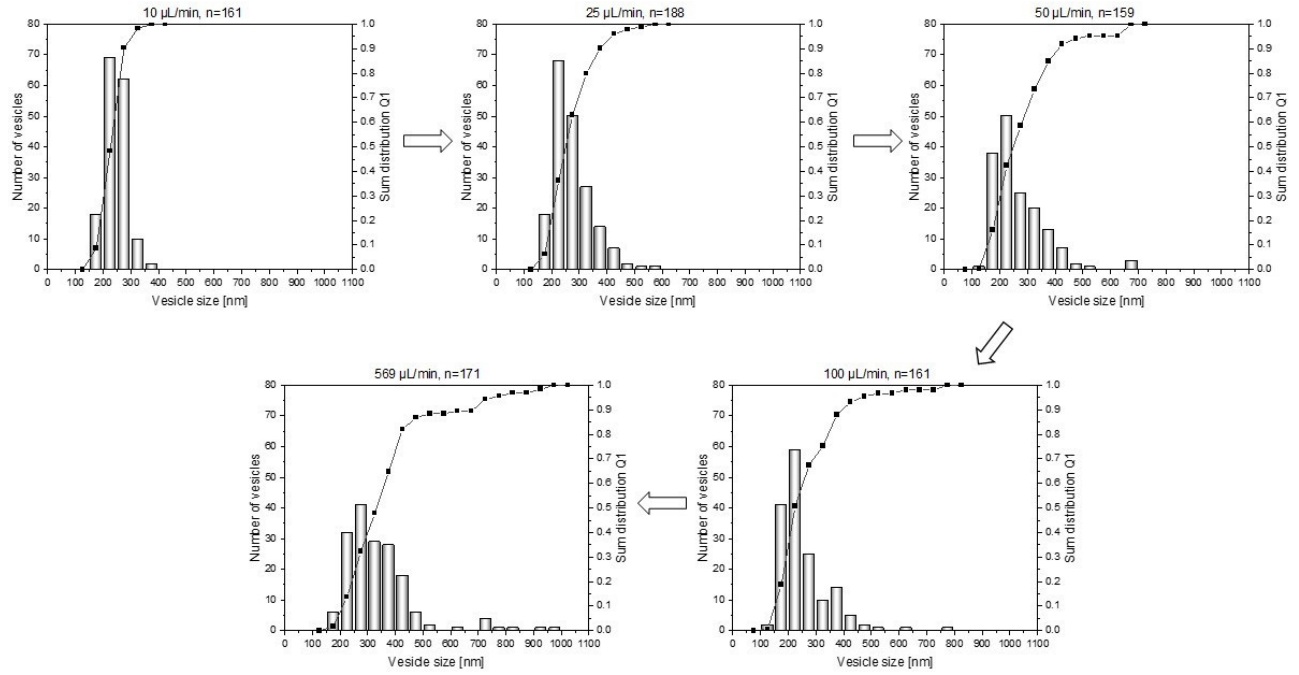
Figure 5. Influence of the addition rate of the selective solvent water on the vesicle size distribution (shown as number distributions (histograms) and sum distributions (line charts)) with THF as good solvent for a water content of 14 wt% and a constant stirring speed of 100 rpm.